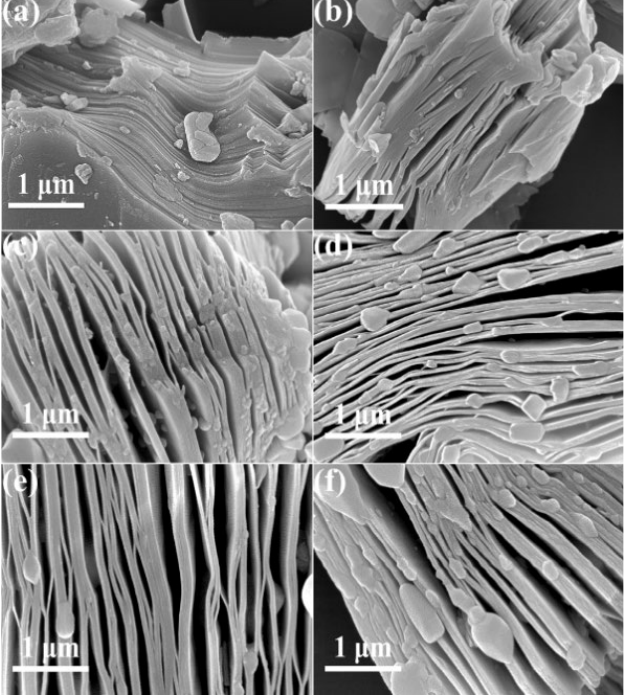
Figure 2. SEM images of ( a ) Ti 3 AlC 2 , ( b ) Ti 3 C 2 T X -24, ( c ) Ti 3 C 2 T X -30, ( d ) Ti 3 C 2 T X -36, ( e ) Ti 3 C 2 T X -42 and ( f ) Ti 3 C 2 T X -48.